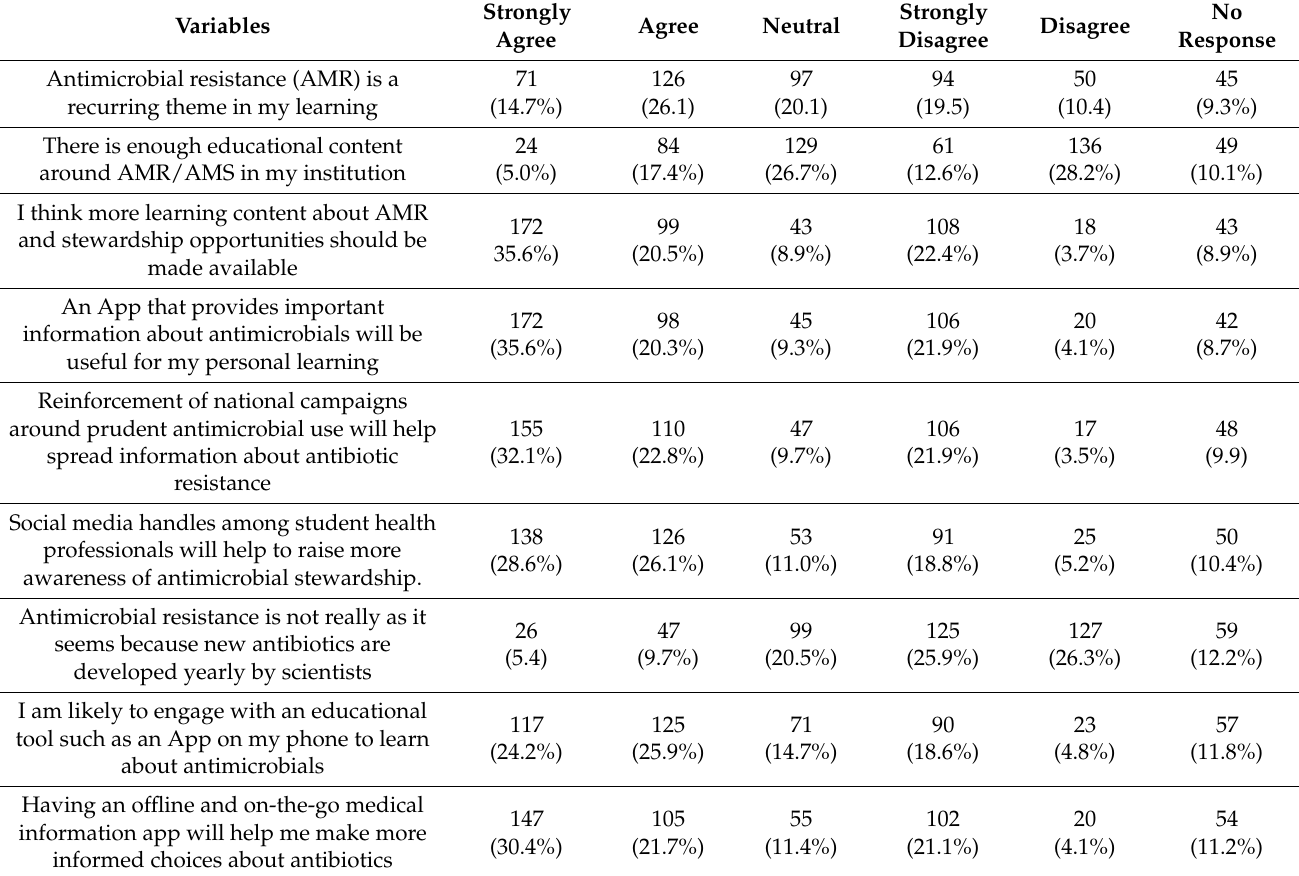
Table 6. Students’ perspectives on antimicrobial resistance and